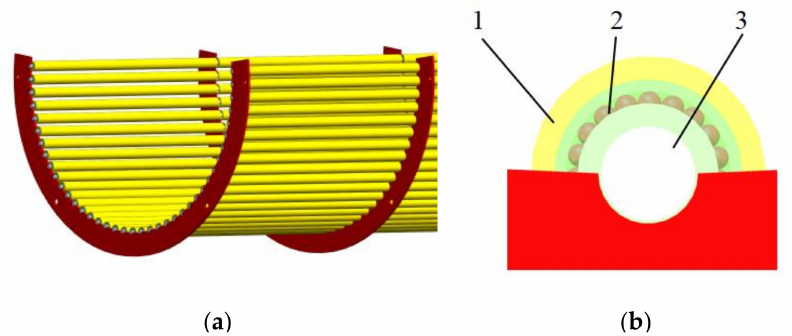
Figure 6. Schematic diagram of micro rotating circular tube concave screen: 1. side arc plate; 2. hollow circular tube rotary screening unit; 3. concave screen support device. Structure diagram of hollow circular tube rotary screening unit: ( a ) the overall structure diagram; ( b ) the side view.